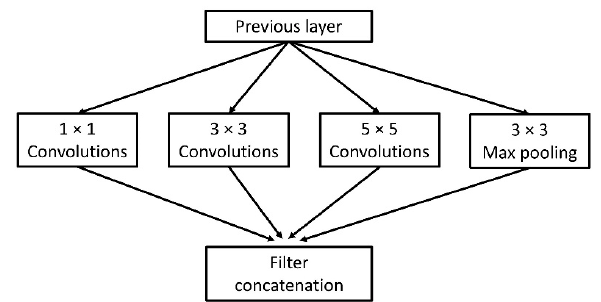
Figure 12. Inception module of GoogLeNet with three different size filters and one pooling layer.